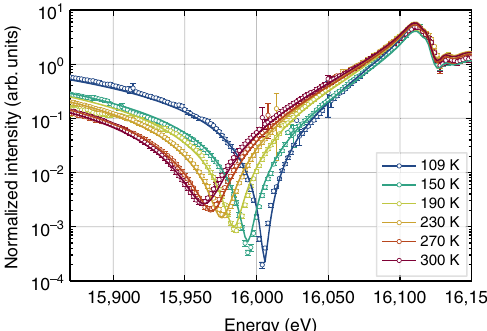
Fig. 2 Temperature response of bulk SrTiO 3 . Energy dependencies of the peak intensity of the 007 Bragg re fl ection near the Sr- K edge are shown for different temperatures. Open circles are the measured values normalized to be on the same scale for each temperature. Error bars indicate the expected SD calculated from the incident and diffracted beam intensity. Solid lines show the fi t after varying the atomic displacement parameters based on absorption corrected kinematic diffraction. The distinct shift of the minimum position is a result of changing Debye – Waller factors due to thermal displacement